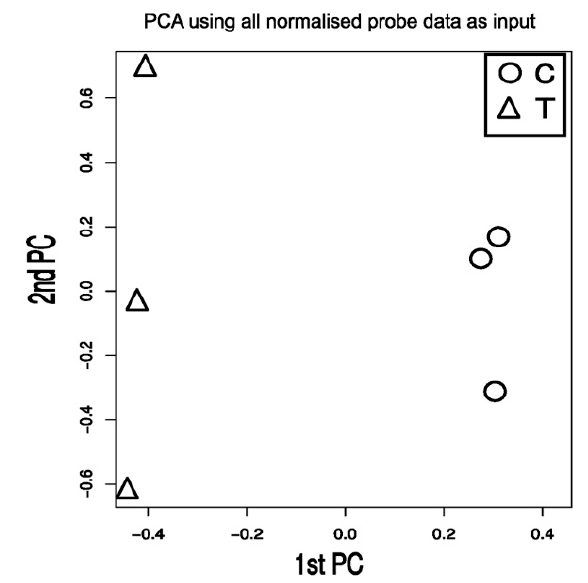
Figure 2. Basic overview of the microarray expression data. Principal component analysis using all measured genes expressed on the microarray as input.